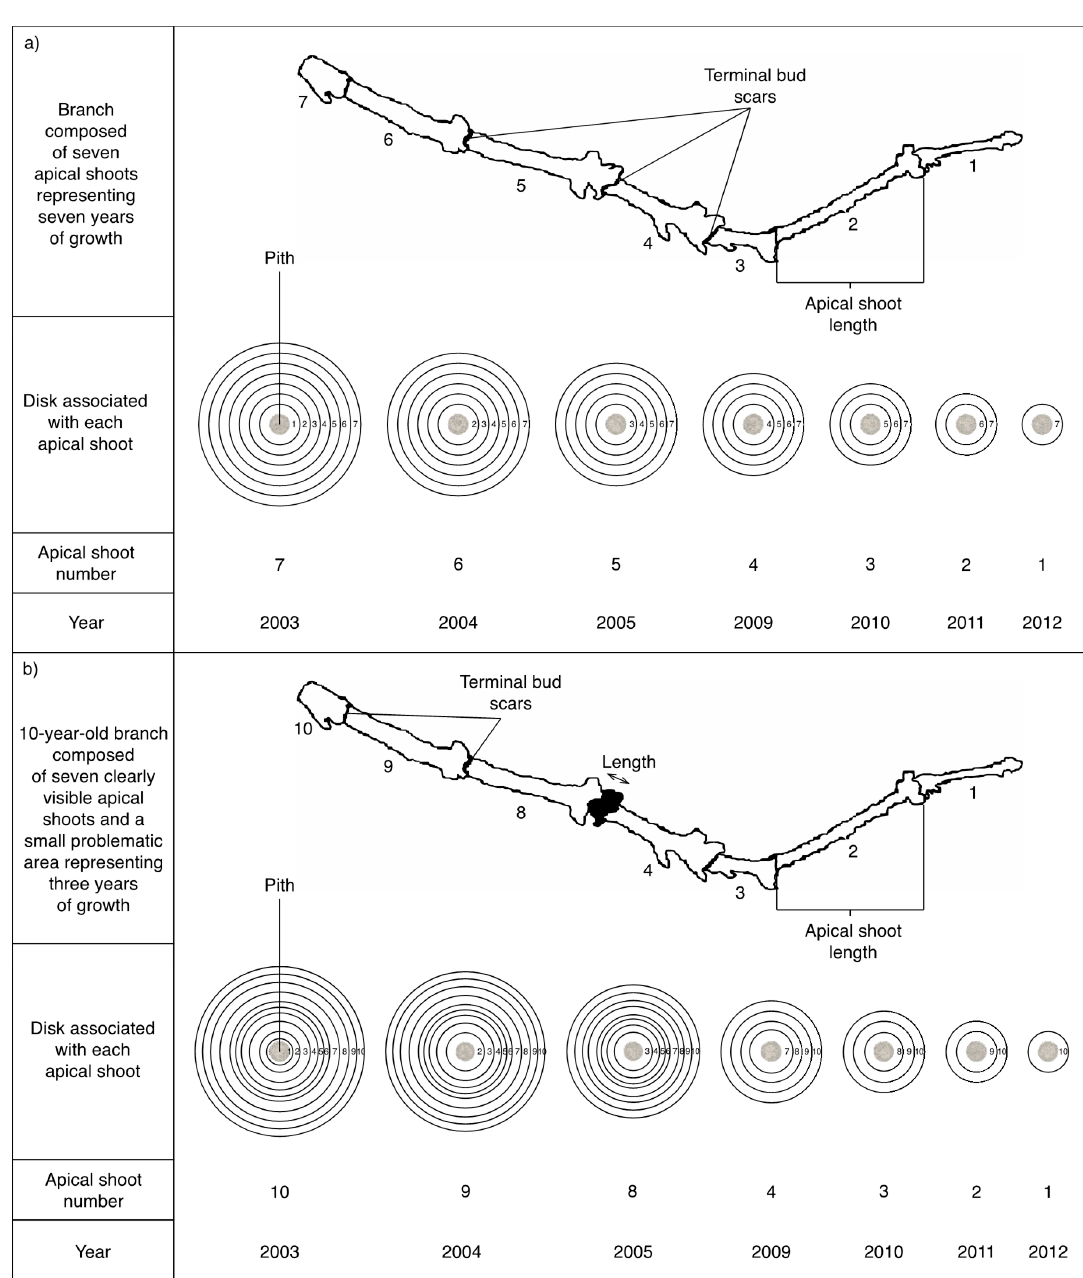
Figure 2. Determination of branch annual primary growth in: ( a ) a normal branch; ( b ) in a branch containing a problematic area (non-visible terminal bud scars). Adapted from Luszczynski [23]. Measurements of primary growth increments were limited to the 20 years prior to CLASS until 10 years post-CLASS, offering a chronology of up to 30 years, depending on branch age. To minimize differences in age and growth between branches, primary growth chronologies were standardized by dividing each annual measurement by the mean increment of the branch before CLASS to obtain an index value for each year [24]. 2.3. Branch Annual Secondary Growth (Radial Increment) From the same branches used for annual primary growth measurements, we collected a disc at the base of the branch for the analysis of secondary growth. All discs were air-dried, sanded with progressively finer grade sandpaper, and their ring widths were measured with a LINTAB™ using